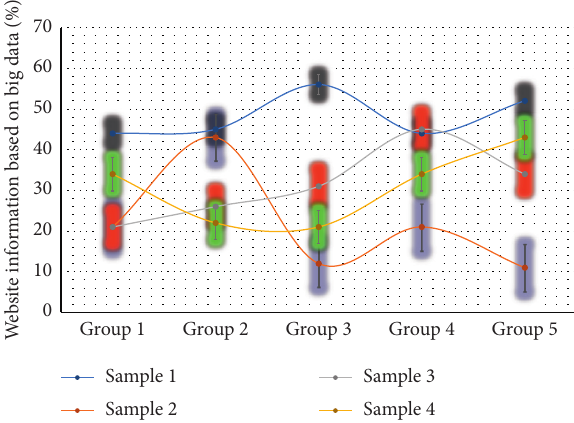
Figure 3: Cluster analysis of website information based on big data.